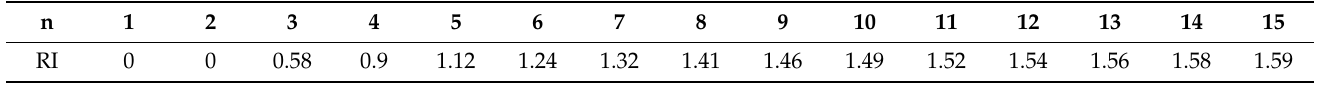
Table 3. Consistency test RI